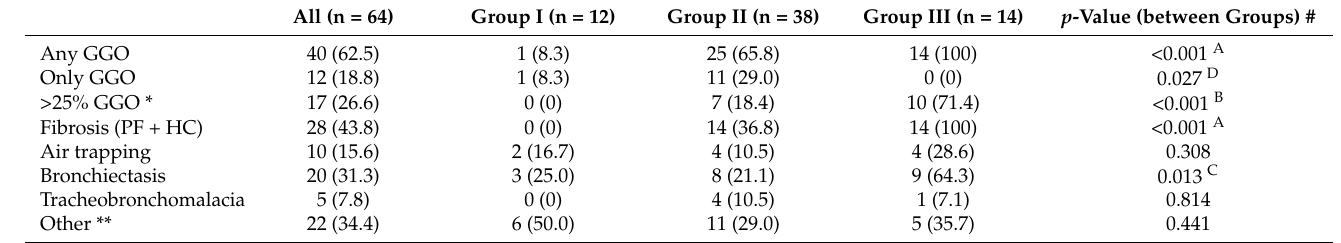
Table 3. HRCT findings in patients 4 months after COVID-19 (n = 63) and differences between patients who were not hospitalised, hospitalised without ICU and with ICU